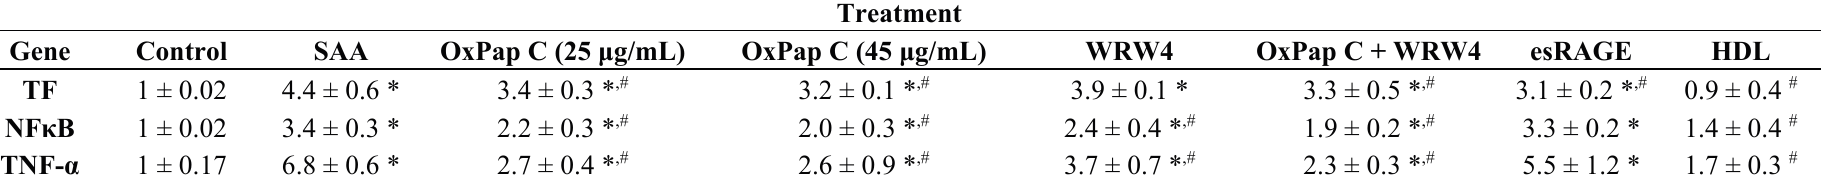
Table 1. HDL suppresses SAA-induced pro-inflammatory and pro-thrombotic gene expression in HCtAEC a